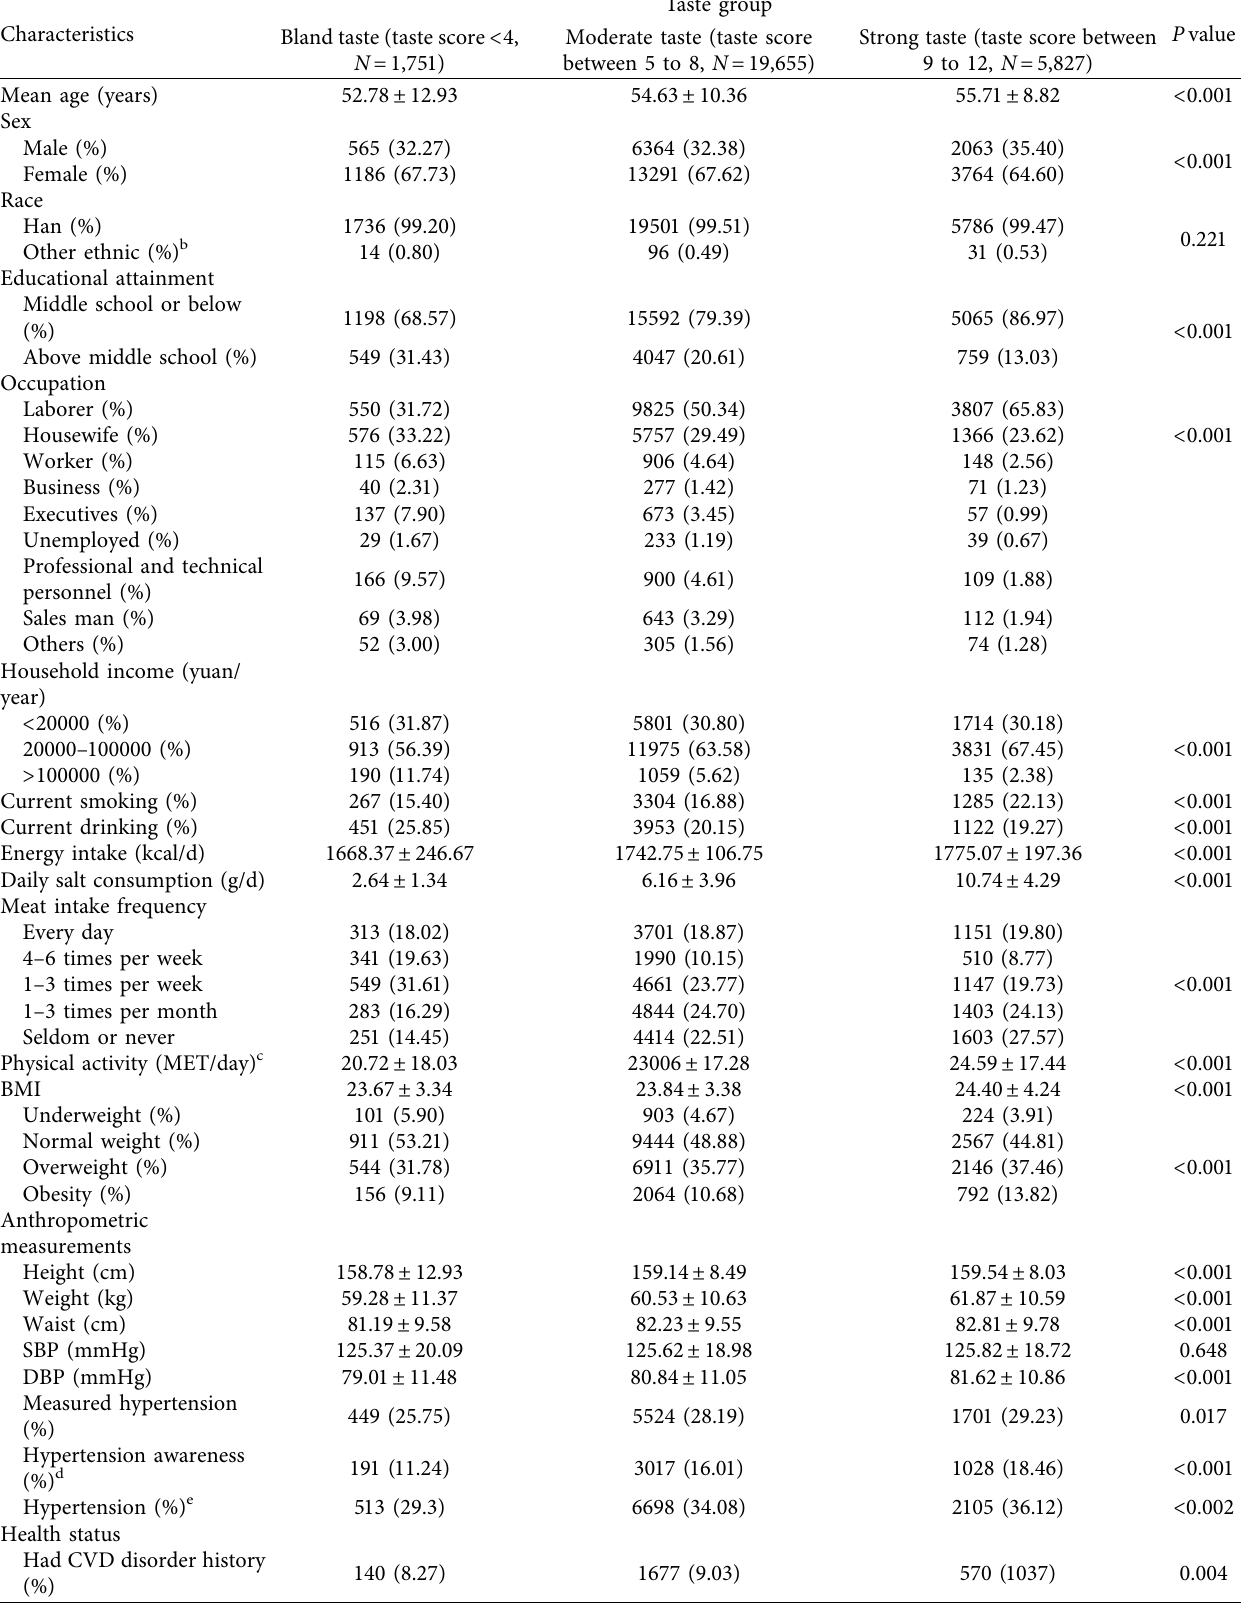
Table 1: Baseline characteristics of the study population according to taste groups a